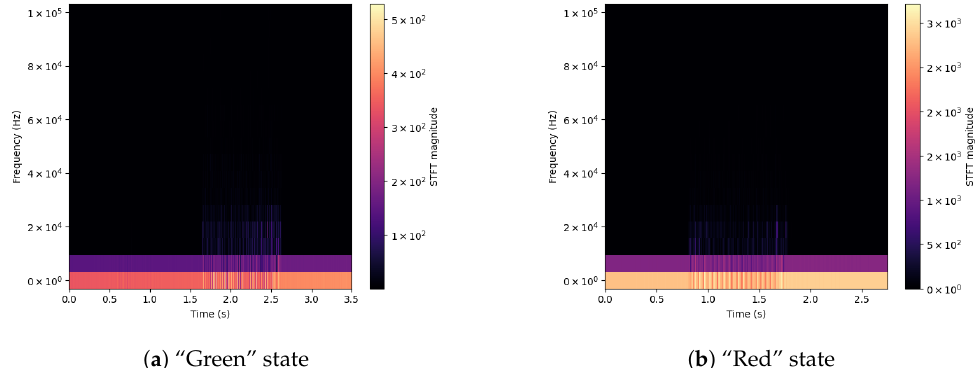
Figure 4. Signal spectrograms of Force X for Green/Red states.